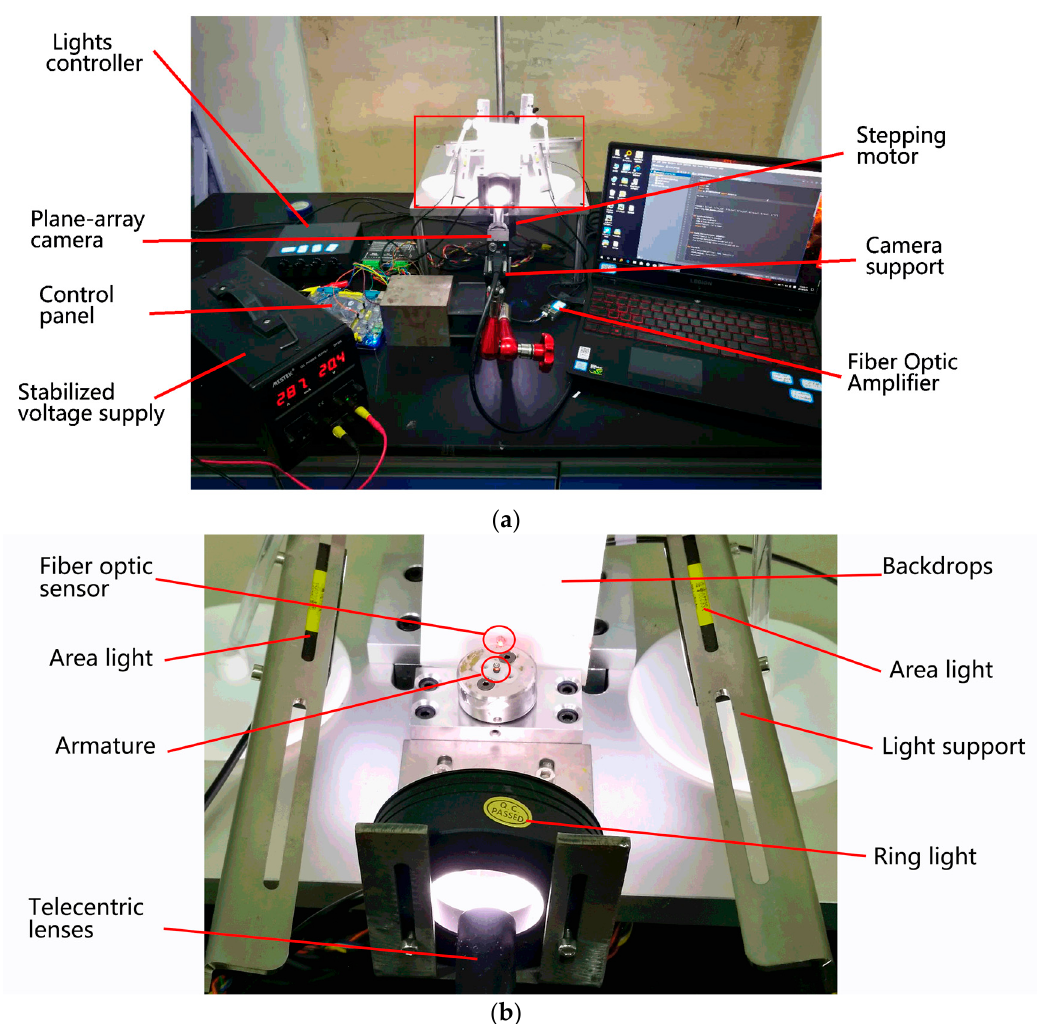
Figure 2. ( a ) Apparatus for the proposed inspection system. ( b ) shows the details in the red box of (a).